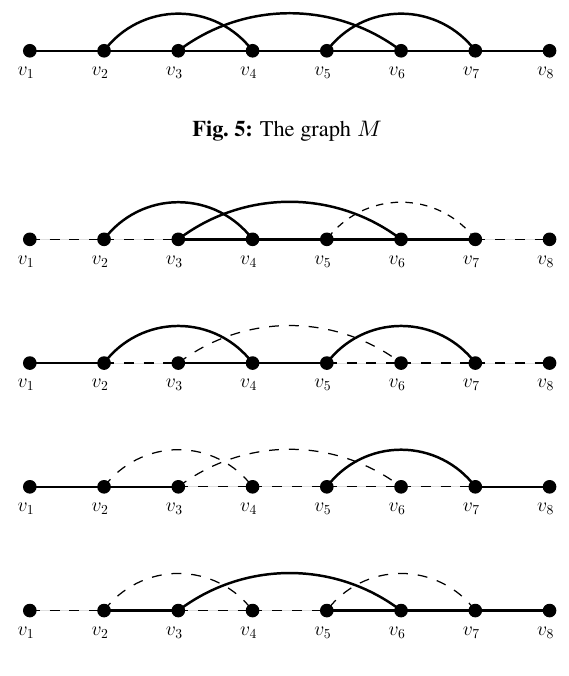
Fig. 6: Possible colorings of